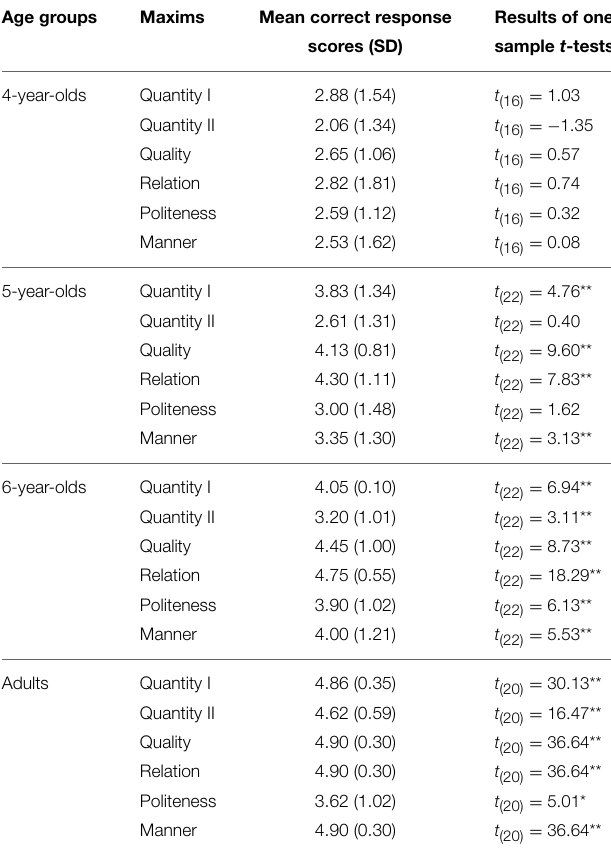
TABLE 1 | Mean numbers of correct responses to CVT and results of one-sample t -tests for all age